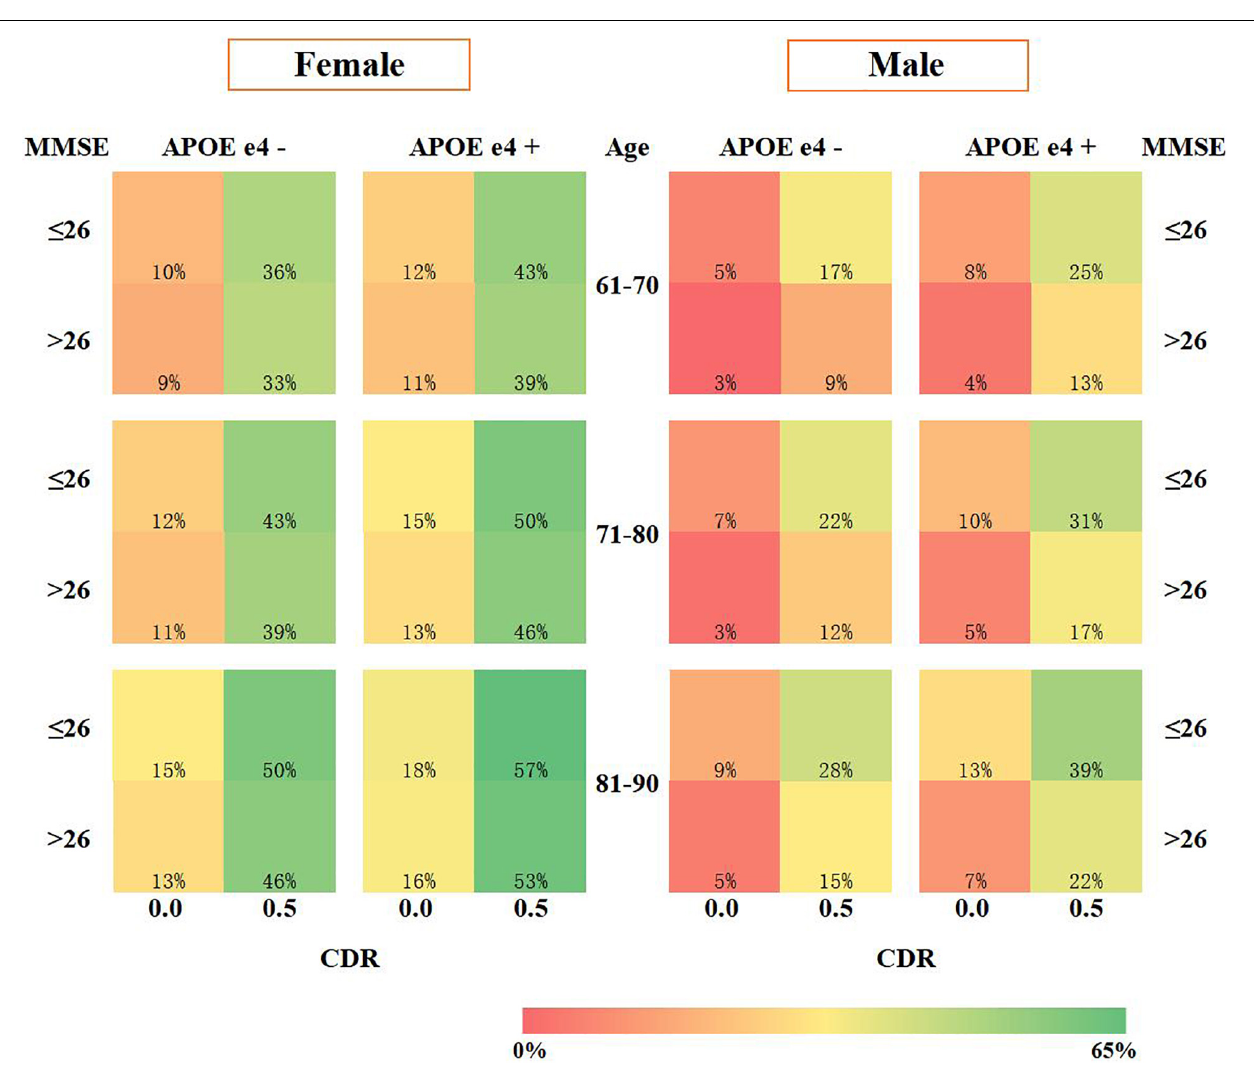
FIGURE 2 | Risk prediction visualization of the